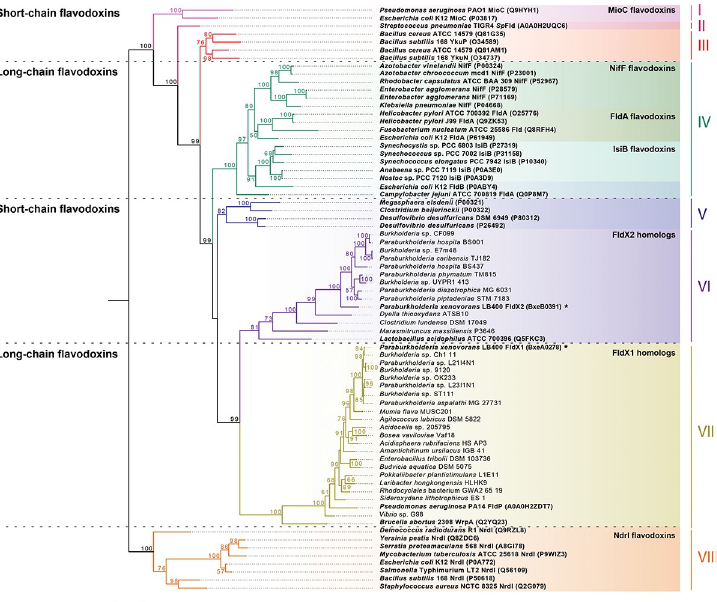
Fig 3. Phylogenetic analysis of P . xenovorans LB400 flavodoxins. NrdI flavodoxins rooted phylogeny showed 8 defined clusters (I-VIII). FldX1 and FldX2 were designated with asterisks ( � ). Bold letters denote experimentally proven flavodoxins. The bootstrap values (percentage) above 50% were shown for each branch point. FldX1 groups with FldP of P . aeruginosa PA14 and WrpA of B . abortus 2308 (cluster VII), while FldX2 groups with flavodoxin-4 of L . acidophilus ATCC 700396 positioned in the cluster